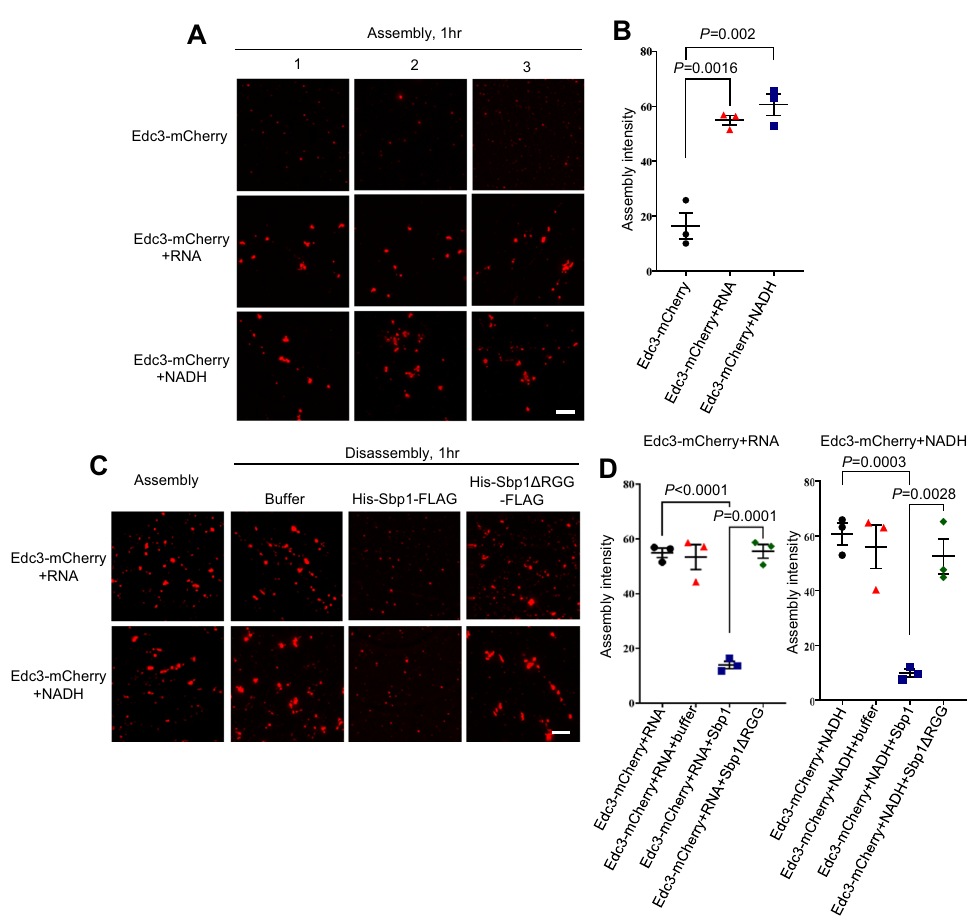
Fig. 7 Puri fi ed Sbp1 disrupts Edc3 assemblies in RGG-motif dependent manner. A Puri fi ed Edc3-mCherry (10 µ M) were kept at 30 °C for 1 hr to phase- separate in LLPS buffer (150 mM KCL; 30 mM HEPES-KOH pH 7.4; 2 mM MgCl 2 ) in presence of RNA or NADH as indicated. 1, 2, and 3 indicate representative images from three independent experiments. Scale Bar, 10 µ m. B Quantitation for A. Data plots represent mean ± SEM from of n = 3, where ‘ n ’ represents number of independent experiments. A two-tailed paired student t -test was used to calculate P -values. C After 1 h, the phase-separated assemblies were subjected to 10 µ M of Sbp1 or Sbp1 Δ RGG protein and incubated again at 30 °C for another 1 h followed by microscopy at each time point during assembly and disassembly. The images were taken using DeltaVision DV Elite microscope. Scale Bar, 10 µ m. D Quantitation of data presented in C . Data plots represent mean ± SEM from of n = 3, where ‘ n ’ represents number of independent experiments. A two-tailed paired student t -test was used to calculate P